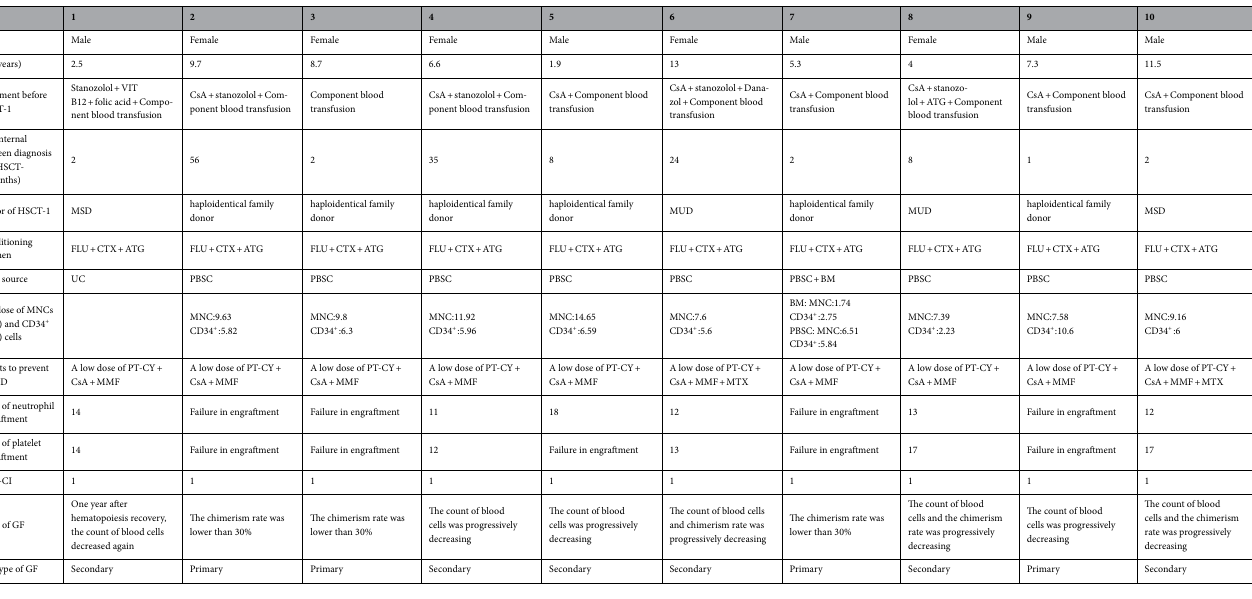
Table 1. The basic information of the pediatric patients of